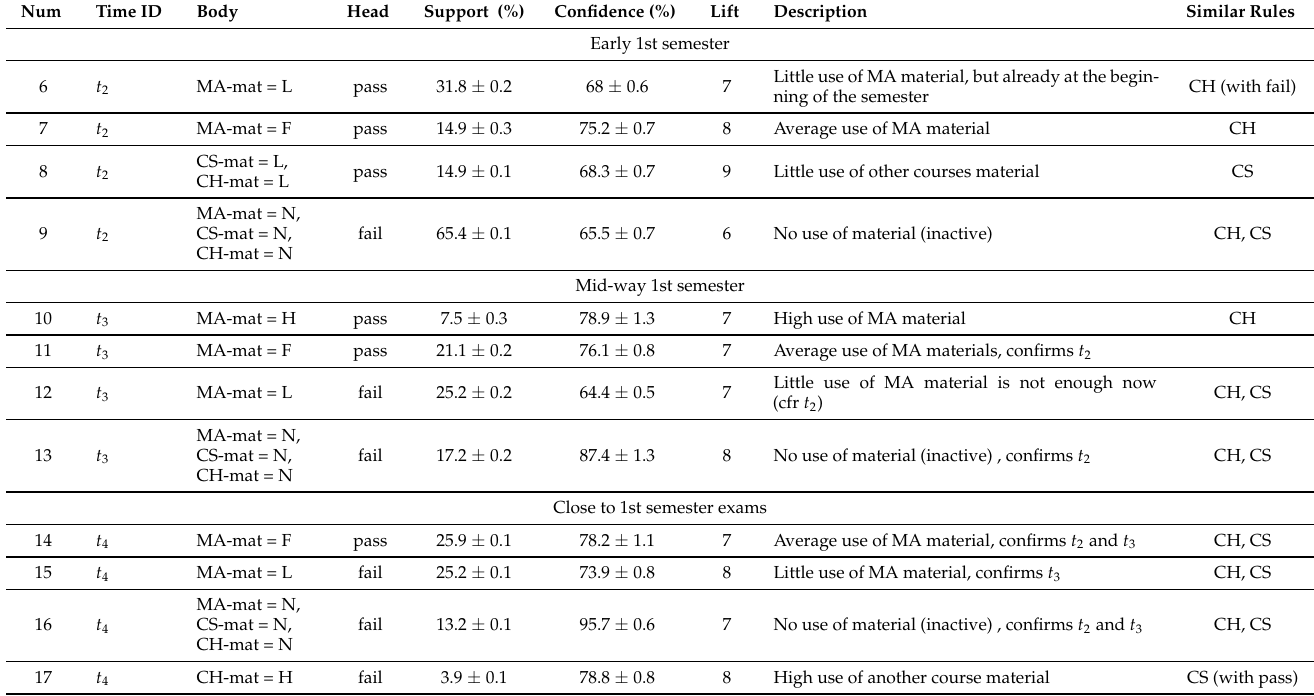
Table 7. High-quality single-feature rules mined from the MA datasets including only T-MAT features. minsup = 1%, minconf = 50%, mincorr = 2. Support and confidence values of each of the selected rules are averaged over the 5 cross- validation folds (average and standard deviation are